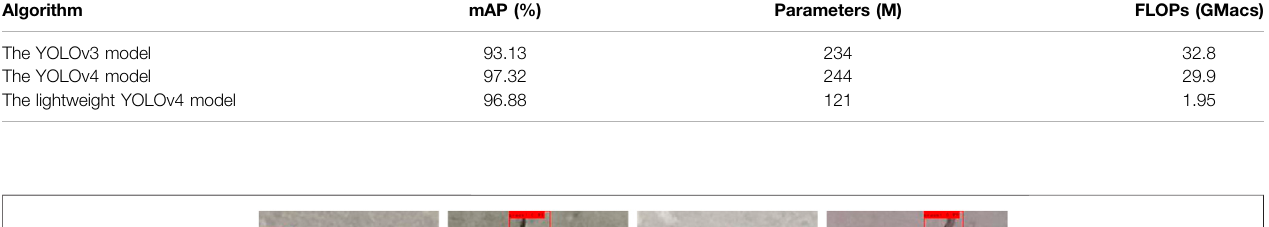
TABLE 4 | The performance comparison of the lightweight YOLOv4 model with the original YOLOv4 model and the YOLOv3 model. Algorithm